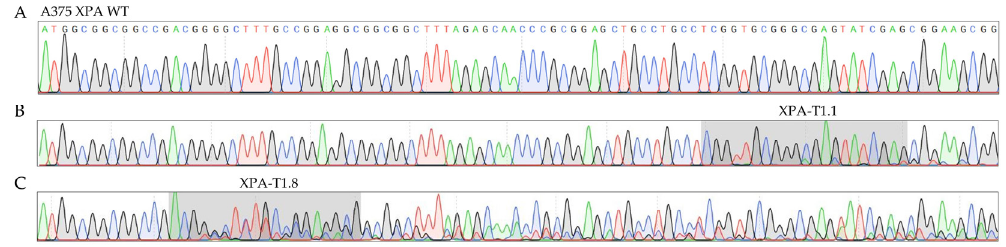
Figure 2. Sanger sequencing chromatograms comparing XPA WT ( A ) and XPA polyclonal cells targeted with sgRNAs T1.1 ( B ) or T1.8 ( C ) in exon 1. The latter were chosen for the generation of single cell clones, whereas T1.1 targeted cells were discarded. The gray regions highlight the DNA sequences targeted by the respective sgRNAs. Four-color chromatogram depicting the four DNA bases adenine (green), cytosine (blue), guanine (gray), and thymine (red). sgRNA, single-guide RNA; WT, wildtype.